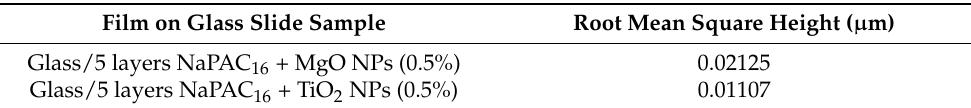
Table 5. Area roughness of composite films deposited on glass slide substrates.